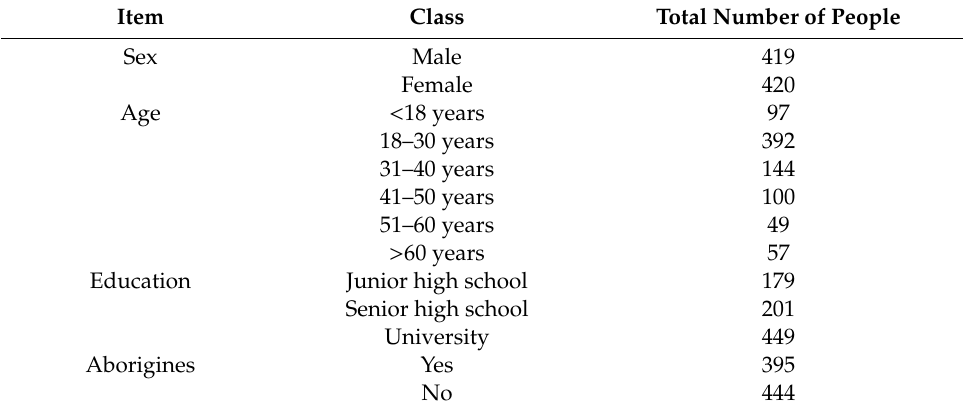
Table 1. Respondent’s characteristics.